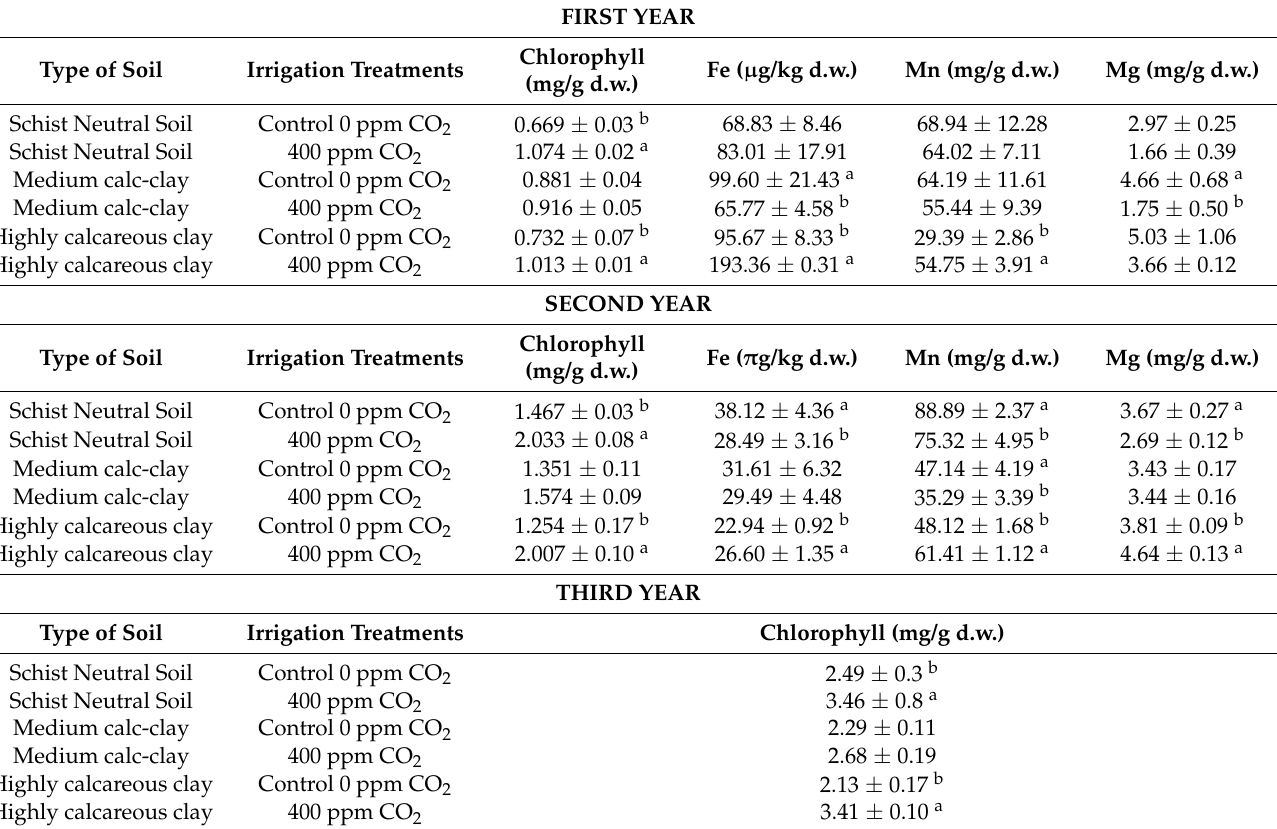
Table 5. Quantitation of chlorophyll (mg/g d.w.), magnesium (Mg mg/g d.w.), iron (Fe µ /g d.w.) and manganese (Mn µ /g d.w.) in dried (d.w.) leaves of V. vinifera cv. Tempranillo. Plants in pots with three different substrates. Treatments: schist soil, medium calcareous soil clay (medium calc-clay), and highly calcareous clay treated with non-acidified water (Control pH 7.5) and 400 ppm CO 2 -acidified water (pH 6.5). a,b : different letters denote a statistically significant difference ( p < 0.05) between treatment for the same type of soil. The results show the mean value and standard